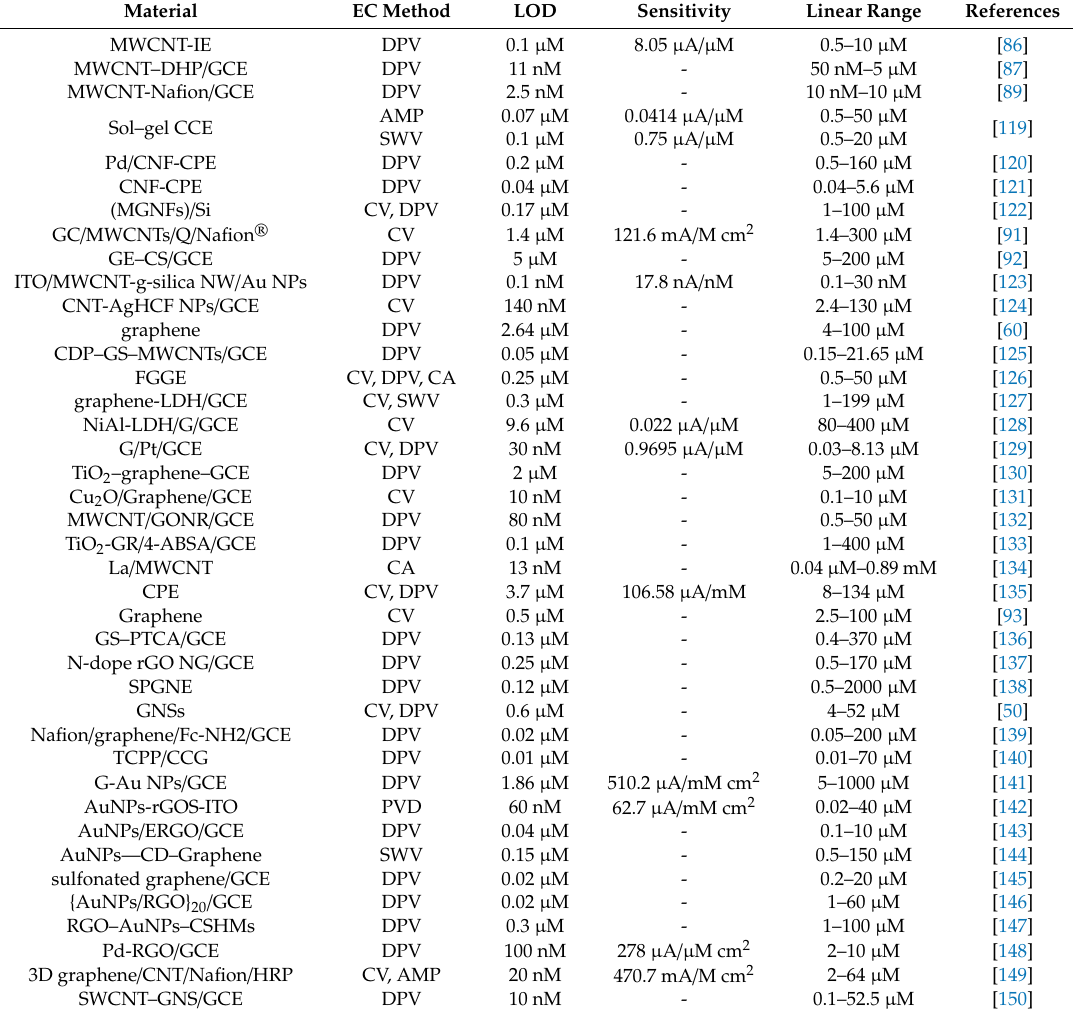
Table 1. Carbon-based electrochemical (EC) sensor for dopamine (DA)